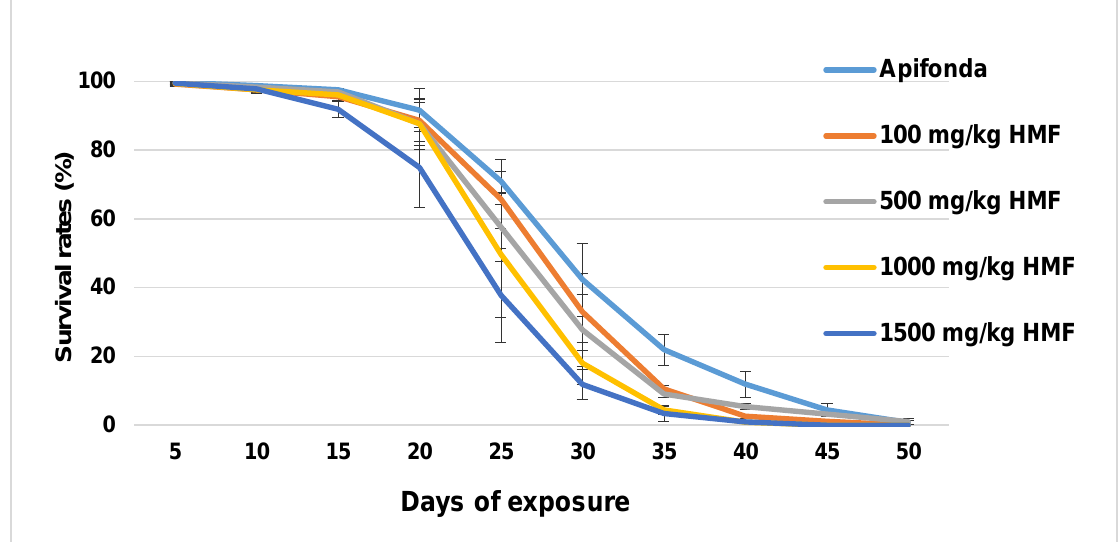
Figure 1. Survival rates of caged bees (expressed in %) are shown in 5 day intervals for each treatment group and the untreated control group (Apifonda). Bars indicate ± SD.